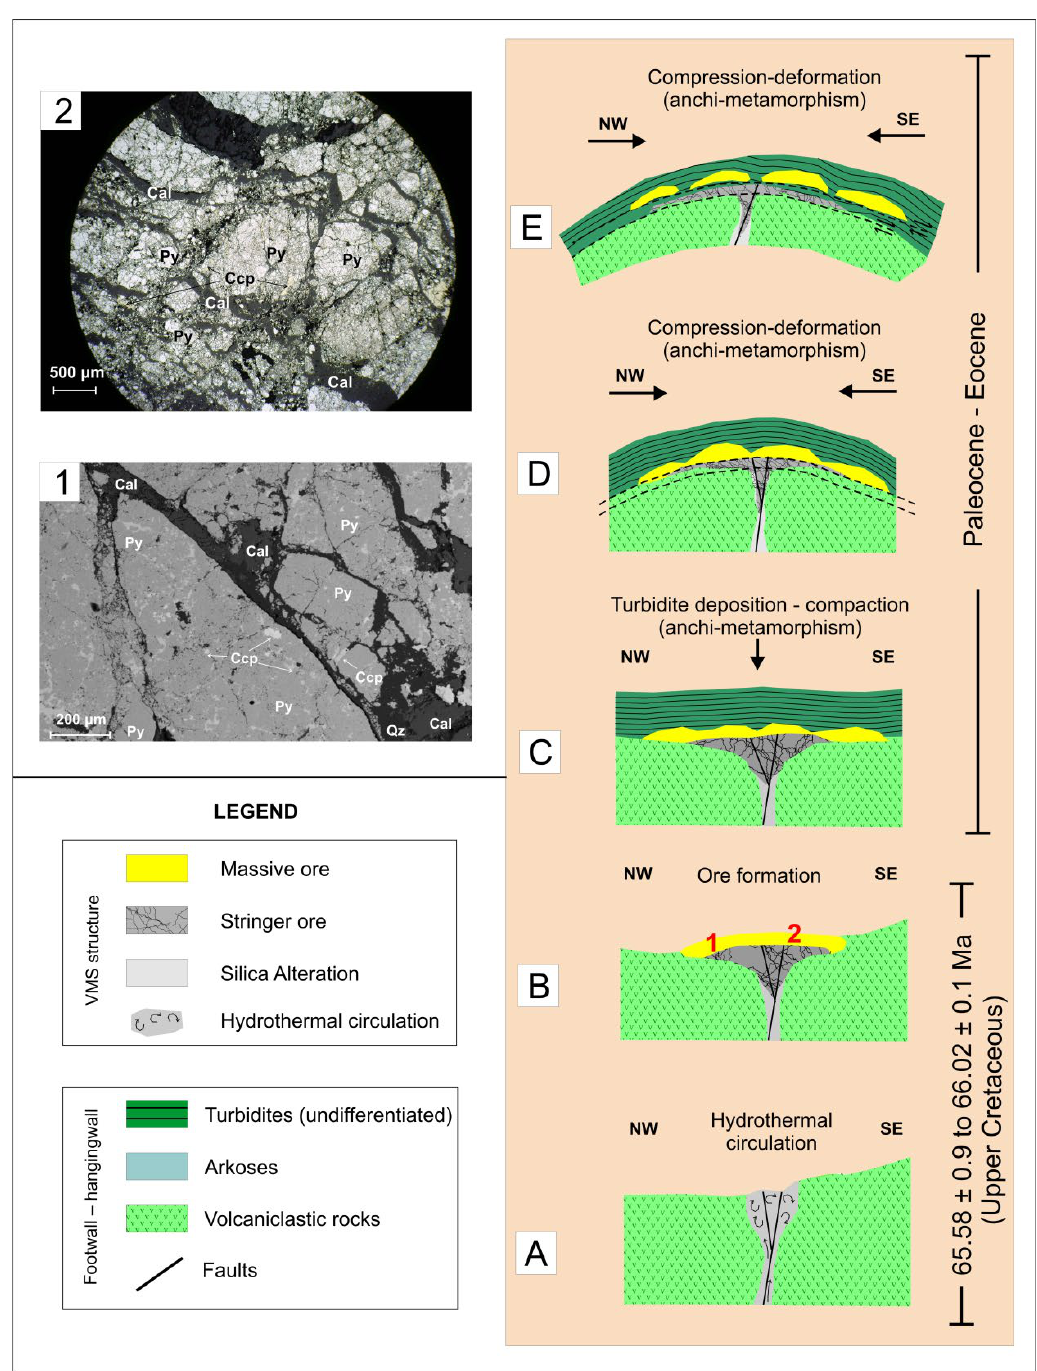
Figure 5. Schematic depiction of the geotectonic evolution of Roro VMS (right side ( A – E )). The Roro VMS was formed easterly (relative to Karakasi) on the seafloor prior turbidite deposition resembling the mode of formation of contemporary mound-shaped massive sulfides. ( 1 – 2 ) Photomicrographs of Roro VMS massive ore and their corresponding position in the Roro VMS. ( 1 ) SEM-EDS image of massive ore from Roro VMS, with abundant pyrite (Py) and minor chalcopyrite (Ccp). ( 2 ) Reflected light optical microscopy image (plain light) of Roro massive ore with typical clastic–sandy texture depicting formation on the seafloor. The angular massive ore fragments with predominant pyrite (Py) and minor chalcopyrite (Ccp) are cemented by later quartz±calcite. (Abbreviations after [95]).